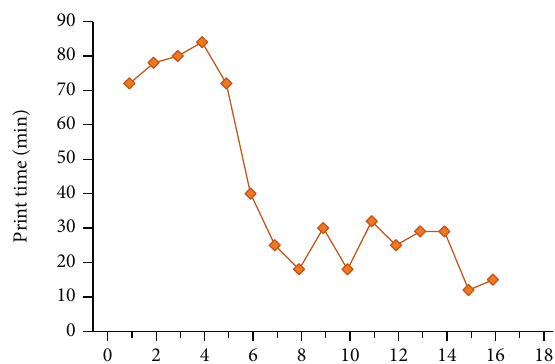
Figure 4: Line chart of printing size error.